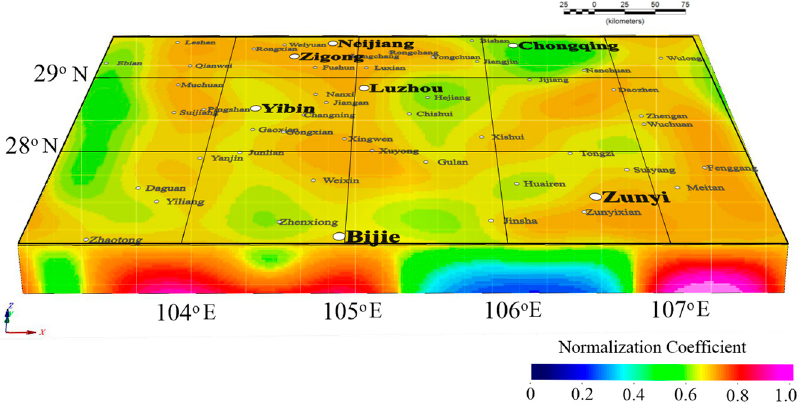
Figure 11. The result of DEXP